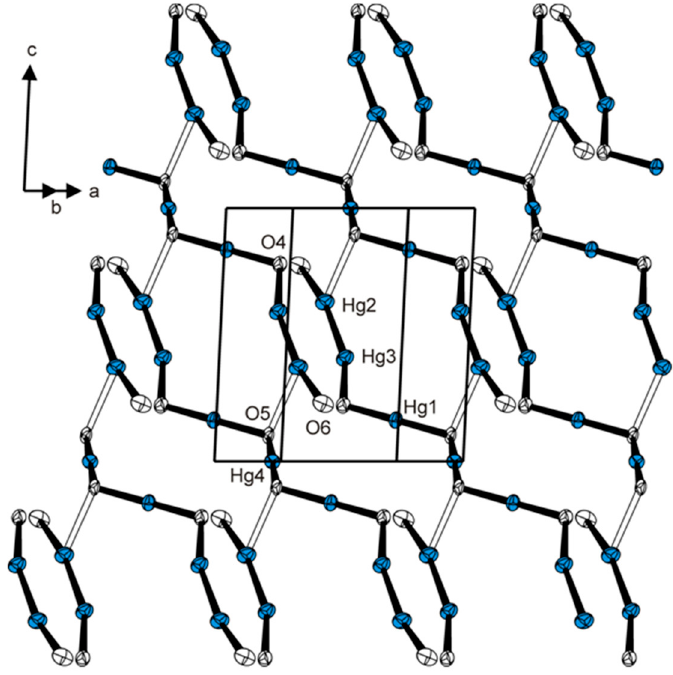
(cid:2) (cid:3) 130 .